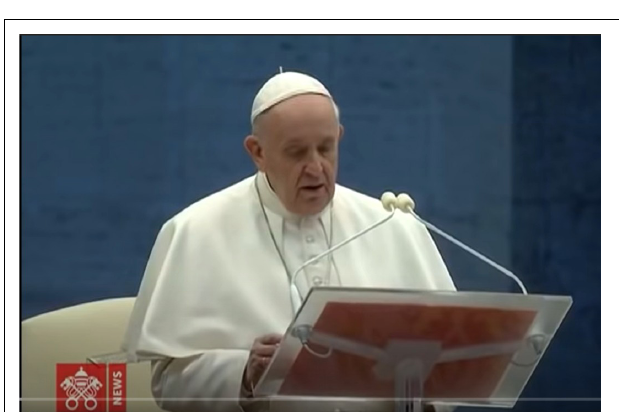
FIGURE 2 | Pope Francis commotion by face (minute 10).